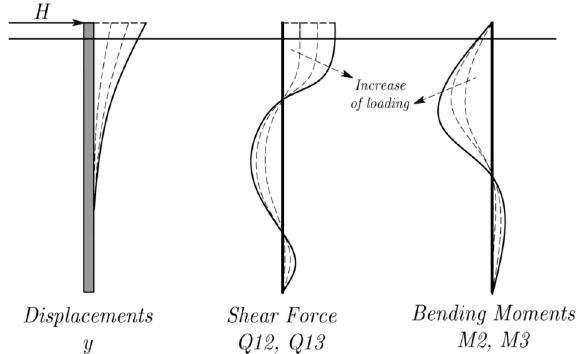
Figure 7. Shape of the characteristic diagrams for a free head pile. Q12, Q13, M2, and M3 denotes the shear forces and bending moments in XY space in PLAXIS 3D, respectively.